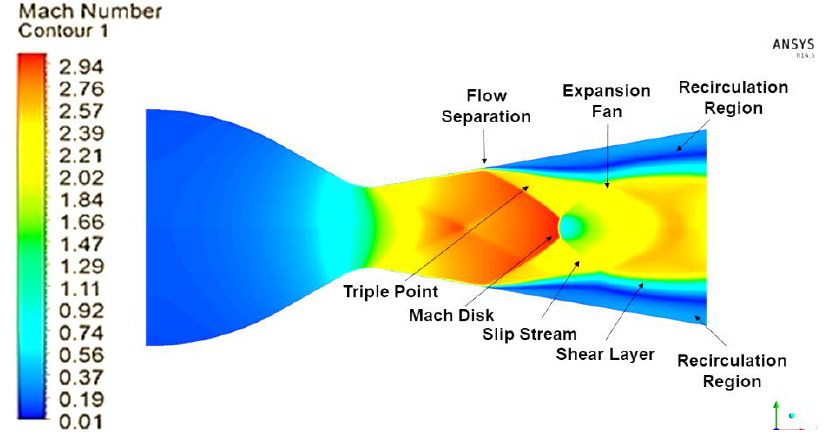
Figure 6. Contour of Mach number showing flow separation point and Mach disk.